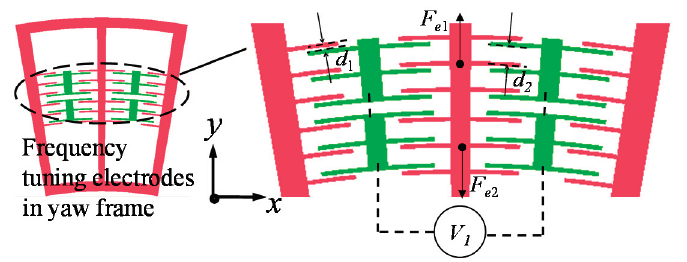
Figure 5. The frequency tuning electrodes in yaw